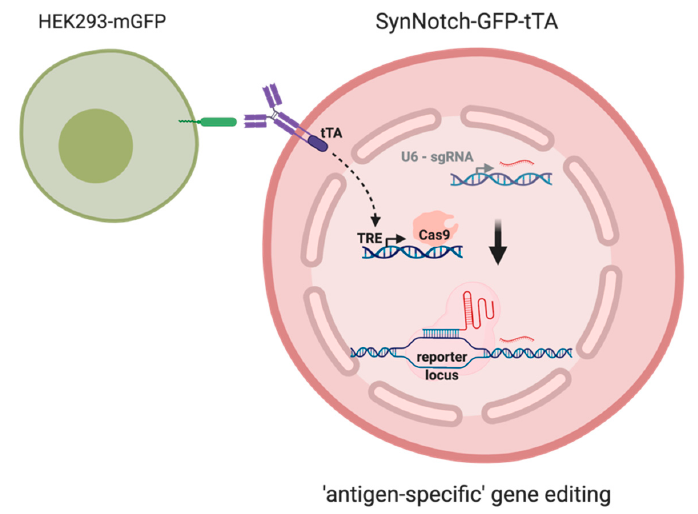
Figure 9. Graphical representation of the presented work: Upon synNotch receptor stimulation, the cytosolic domain of the receptor (tTA, tetracyclin transactivator) gets released and is able to activate the expression of the Cas9 via the Tet-responsive elements (TREs) in the promoter sequence. Guided by constitutively expressed gRNA, the Cas9 initiates a double-strand break next to the protospacer adjacent motif (PAM) sequence. During non-homologous end joining (NHEJ)-mediated DNA repair, a indel formation occurs and can be detected with DNA sequencing approaches. Thus, a transient cellular event could be stored as permanent information in the cell’s DNA.